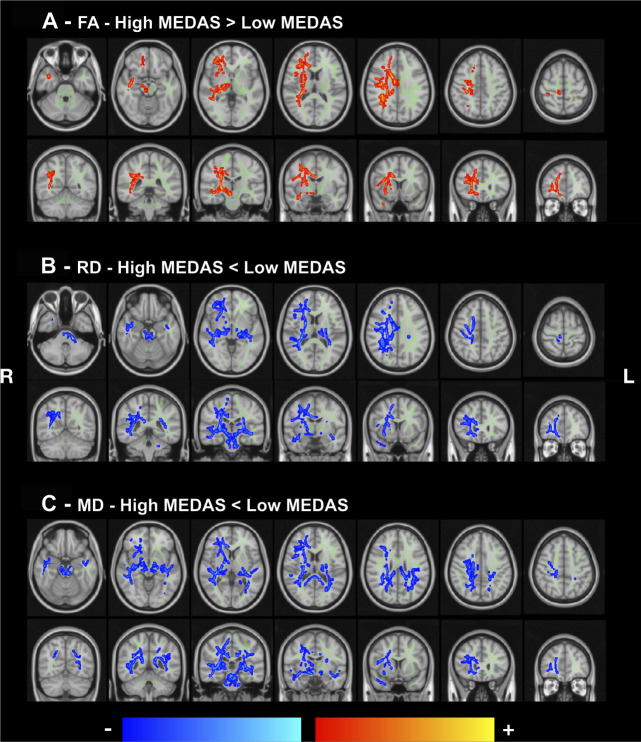
White matter integrity as a function of the MedDiet adherence. Statistically significant group differences in FA (A), RD (B), and MD (C) projected maps, controlled for body mass index (BMI), years of education, time between assessments, sex, and age. Blue/light-blue gradient indicates lower values for the high adherence group when compared to the low adherence group. Red/yellow gradient indicates higher values for the higher adherence group when compared to the low adherence group. Significance threshold was set to p < 0.05 (FWE corrected for multiple comparisons). (A) High MedDiet score is associated with higher fractional anisotropy. (B,C) Low MedDiet score is associated with higher radial and mean diffusivity. MEDAS, Mediterranean Diet Assessment Screener; FA, fractional anisotropy; RD, radial diffusivity; MD, mean diffusivity; R, right; L, left.